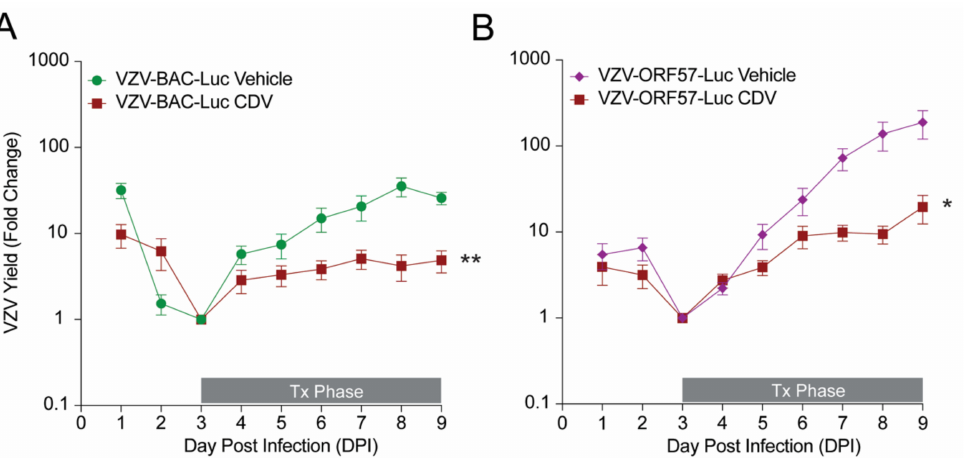
Figure 3. Evaluation of VZV-BAC-Luc and VZV-ORF57-Luc growth kinetics and responses to antiviral treatment in a SCIDhu mouse model. SCID beige mice were implanted with a single subcutaneous xenograft of fetal human skin. Xenografts were inoculated 3–4 weeks later with ( A ) VZV-BAC-Luc or ( B ) VZV-ORF57-Luc by intra-xenograft injection (1 × 10 4 –10 5 pfu/mL; 60 µ L injection; grown in HFFs). Mice were treated with vehicle (water) or 10 mg/kg/day cidofovir (CDV) by intraperitoneal injection from DPI 3 to 9 (Tx Phase). VZV yield was measured daily by bioluminescence imaging and the fold change was calculated as Total Flux each day divided by the lowest Total Flux value per mouse (usually taken on DPI 2 or 3). Virus growth kinetics were evaluated for statistical significance on DPI 9. Symbols represent mean ± SEM. Student’s t -test; asterisks indicate significance between vehicle and cidofovir groups (* p < 0.05; ** p < 0.01). n = 6–10 mice per